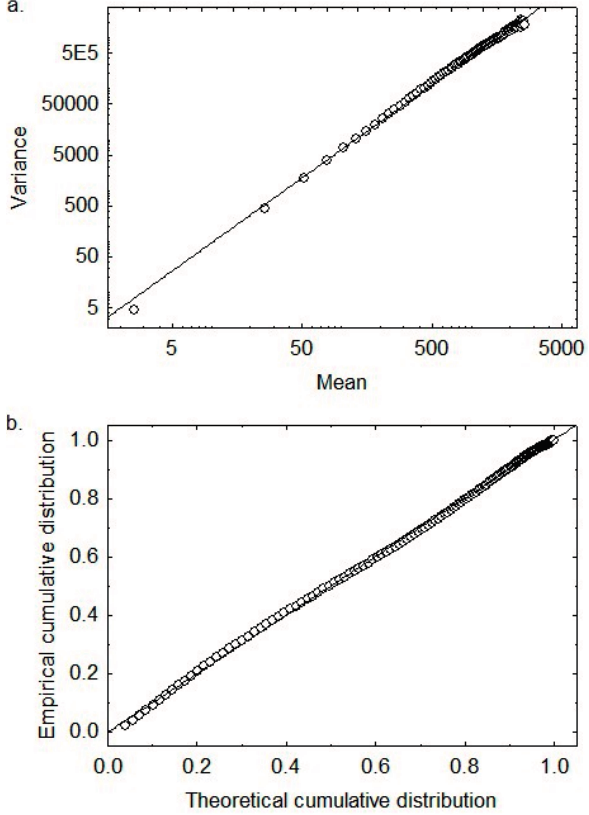
Figure 2. ( a ) The variance function for the deviations of the prime